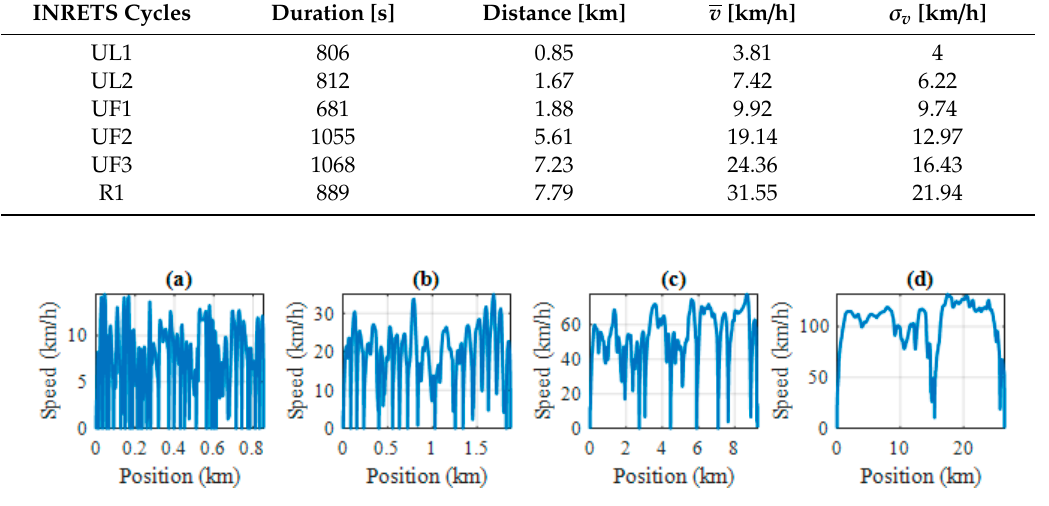
Figure 7. INRETS driving cycles: ( a ) UL1, ( b ) UF1, ( c ) R2 ( d ) A2.